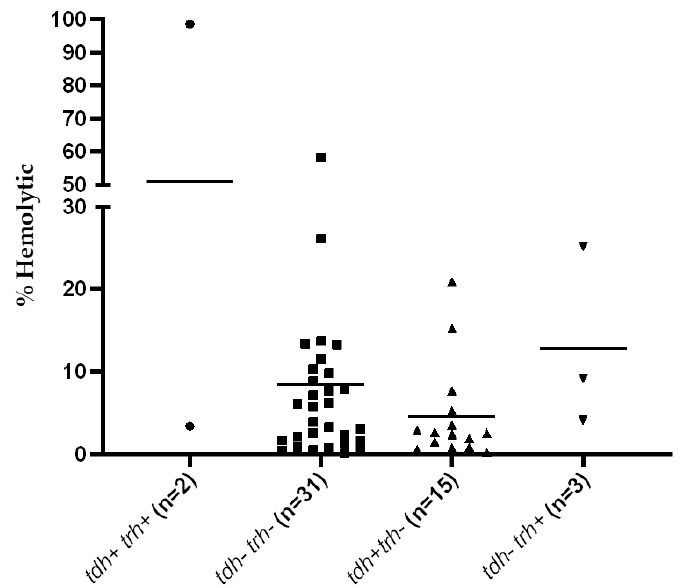
Figure 1. Quantitative analysis of the hemolytic activity of V. parahaemolyticus seafood isolates. Each point shows the mean value from duplicate experiments. Median values are shown by a horizontal line.